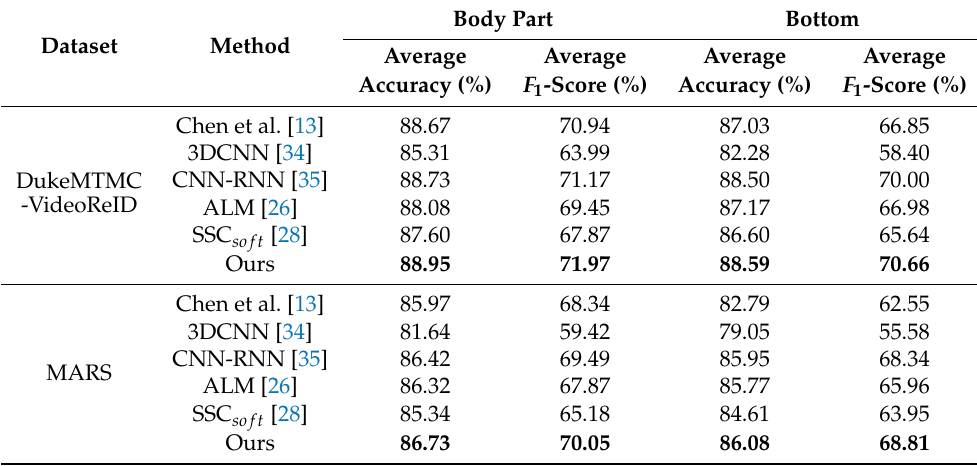
Table 6. Comparisons of the results for the two occlusion scenarios of the DukeMTMC-VideoReID and MARS datasets. The bold indicates the best